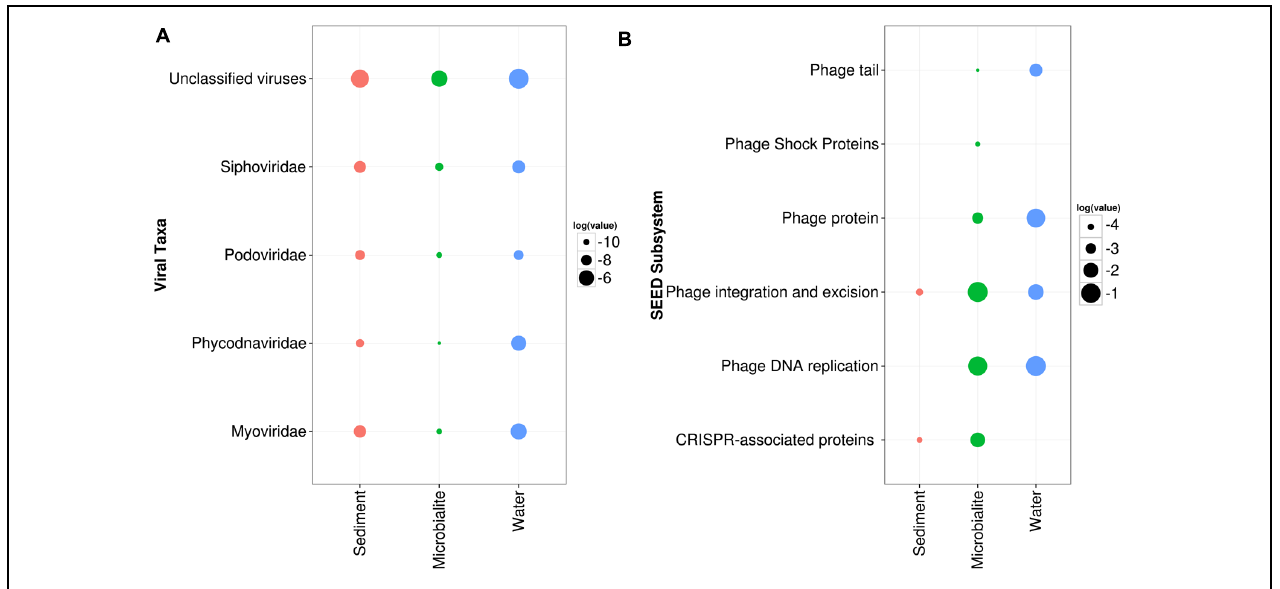
FIGURE 5 | Pavilion Lake viral community composition and metabolic potential. (A) Dotplot of normalized RefSeq viral taxonomic groups in relation to the surrounding environments (e.g., sediments and water) in log relative abundances. (B) Dotplot of the normalized SEED subsystem in relation to the surrounding environments (e.g., sediments and water) in log relative